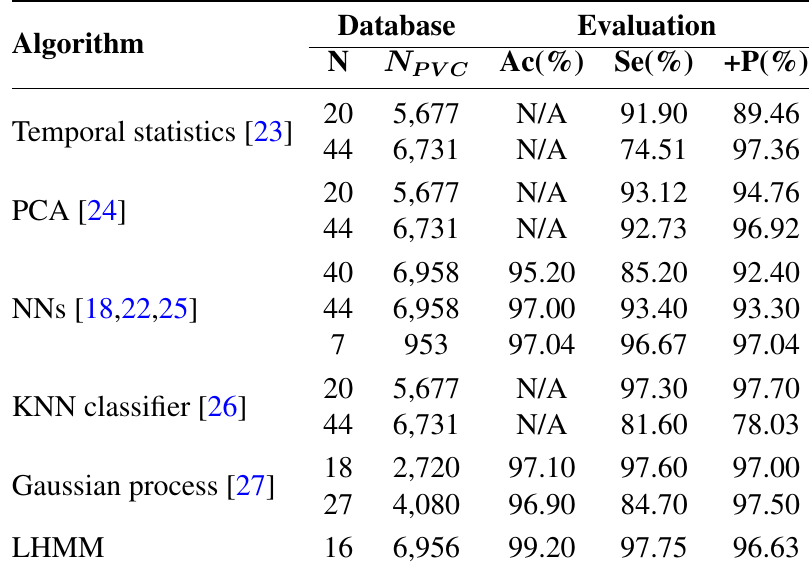
Table 4. Performance comparison on PVC detection. N is denoted as the number of records used in the test and N is the total number of PVCs which have been PV C